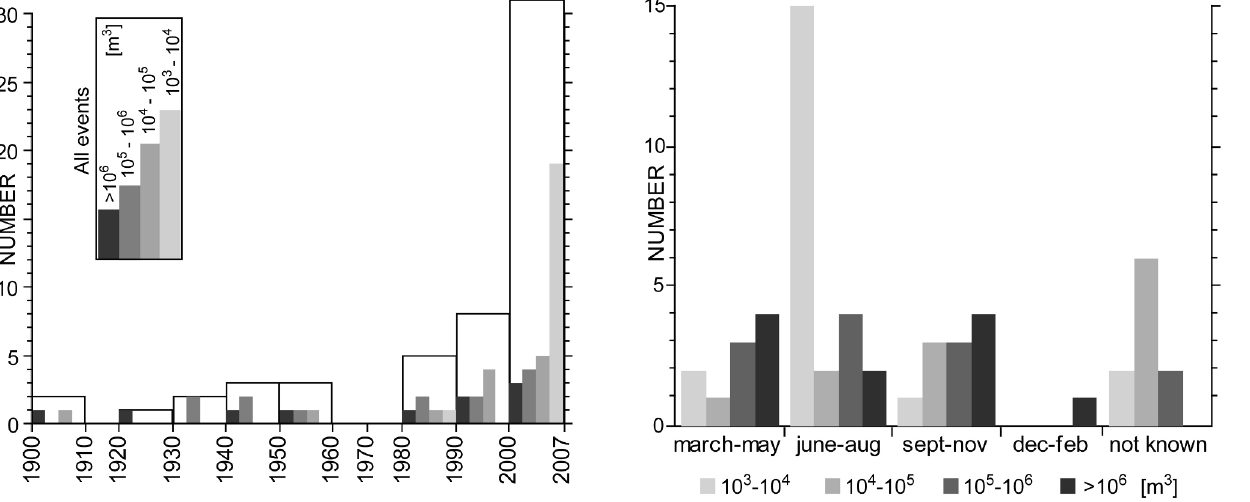
Fig. 4. Number of slope failure records per decade, divided into four volume classes. The increased number in the past three decades has to be considered with caution especially for the small-volume events because of the increased recording activities during this period.